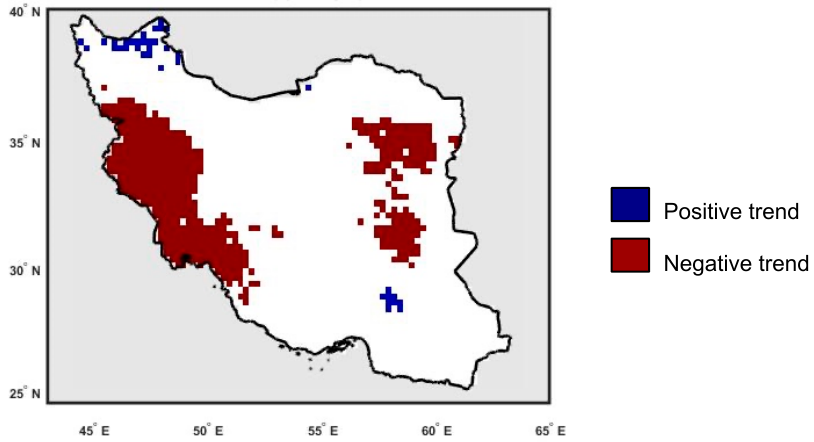
Figure 2. The spatial distribution map of trends in the annual precipitation based on PERSIANN-CDR for the period 1983–2018.